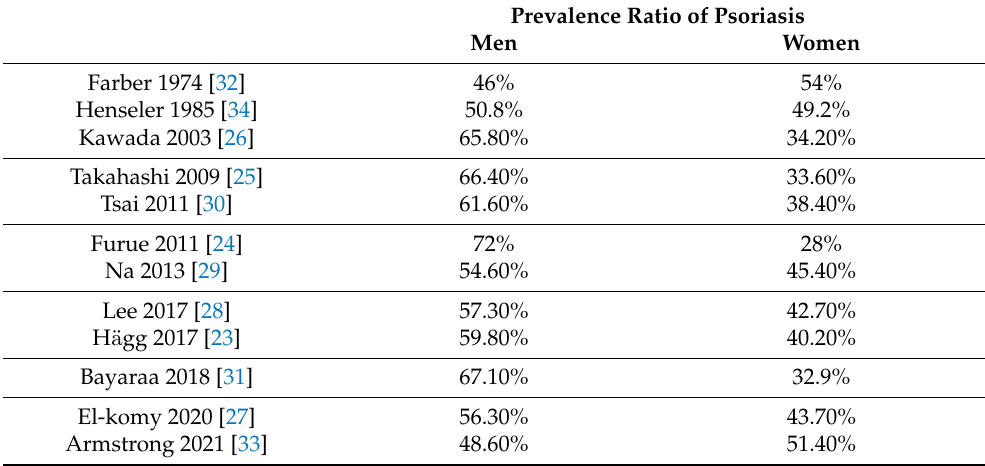
Table 1. A summary of previous reports on the prevalence ratio of psoriasis between men and women.